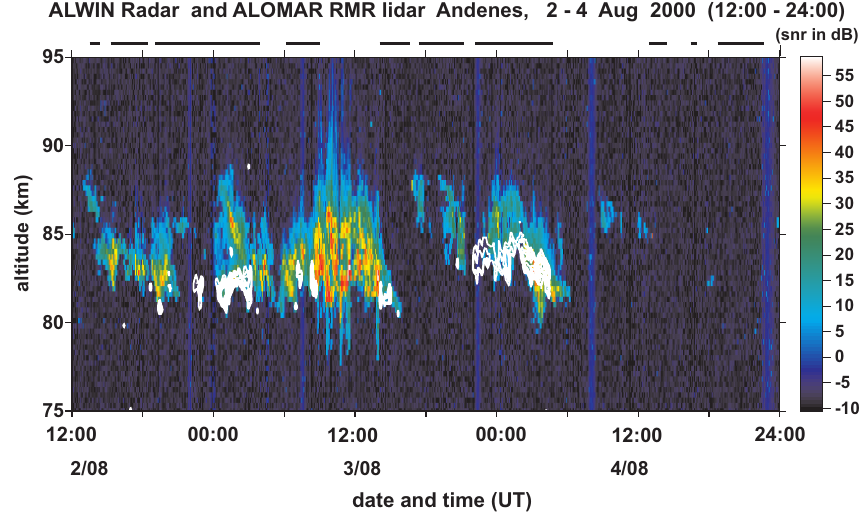
Fig. 7. Observational results: Simultaneous and common volume measurements of PMSE and NLC (white contour lines) during the period of enhanced semidiurnal tidal wave activity. The line at the top indicates when lidar observations have been carried out.